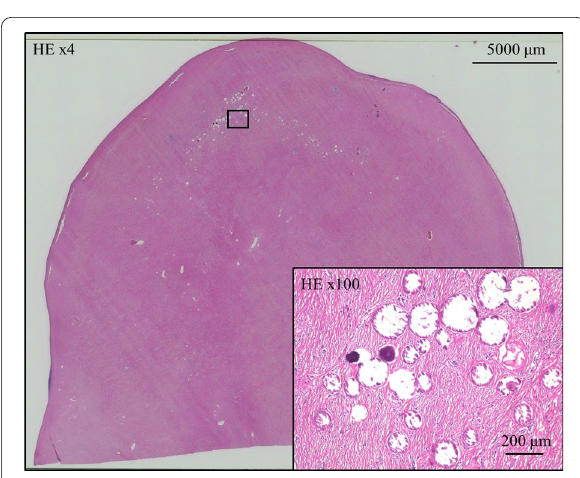
Fig. 3 Microscopic findings. A tumor was well-circumscribed and unencapsulated in a low-power field. A few spindle cells and lymphoplasmacytic infiltration were observed with dense hyalinized collagen and interspersed calcification in the background in a high-power field. HE